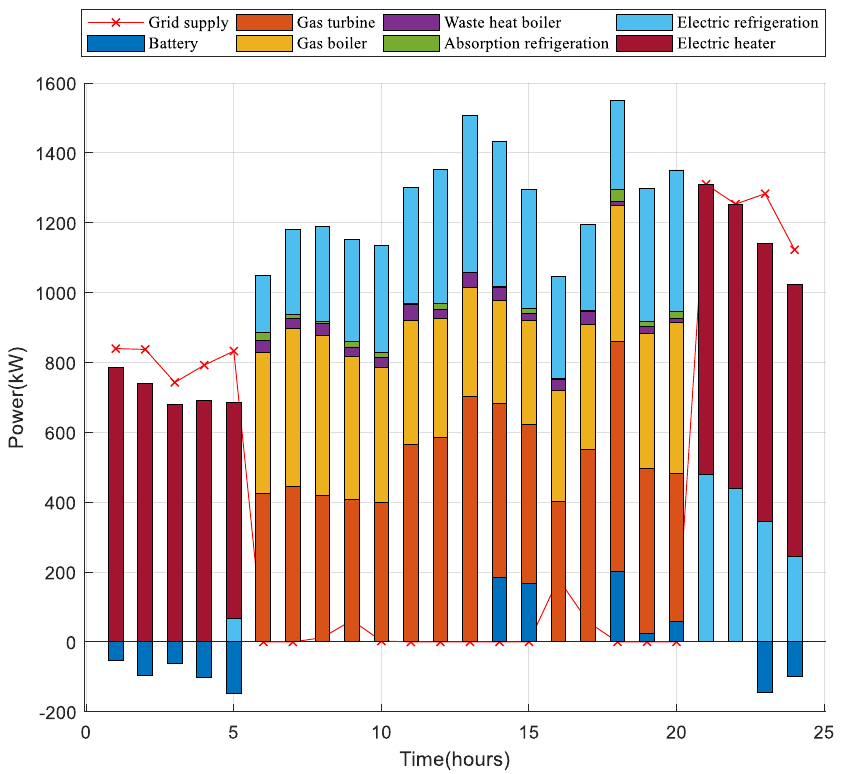
Figure 8. Typical daily optimal results in the winter season.